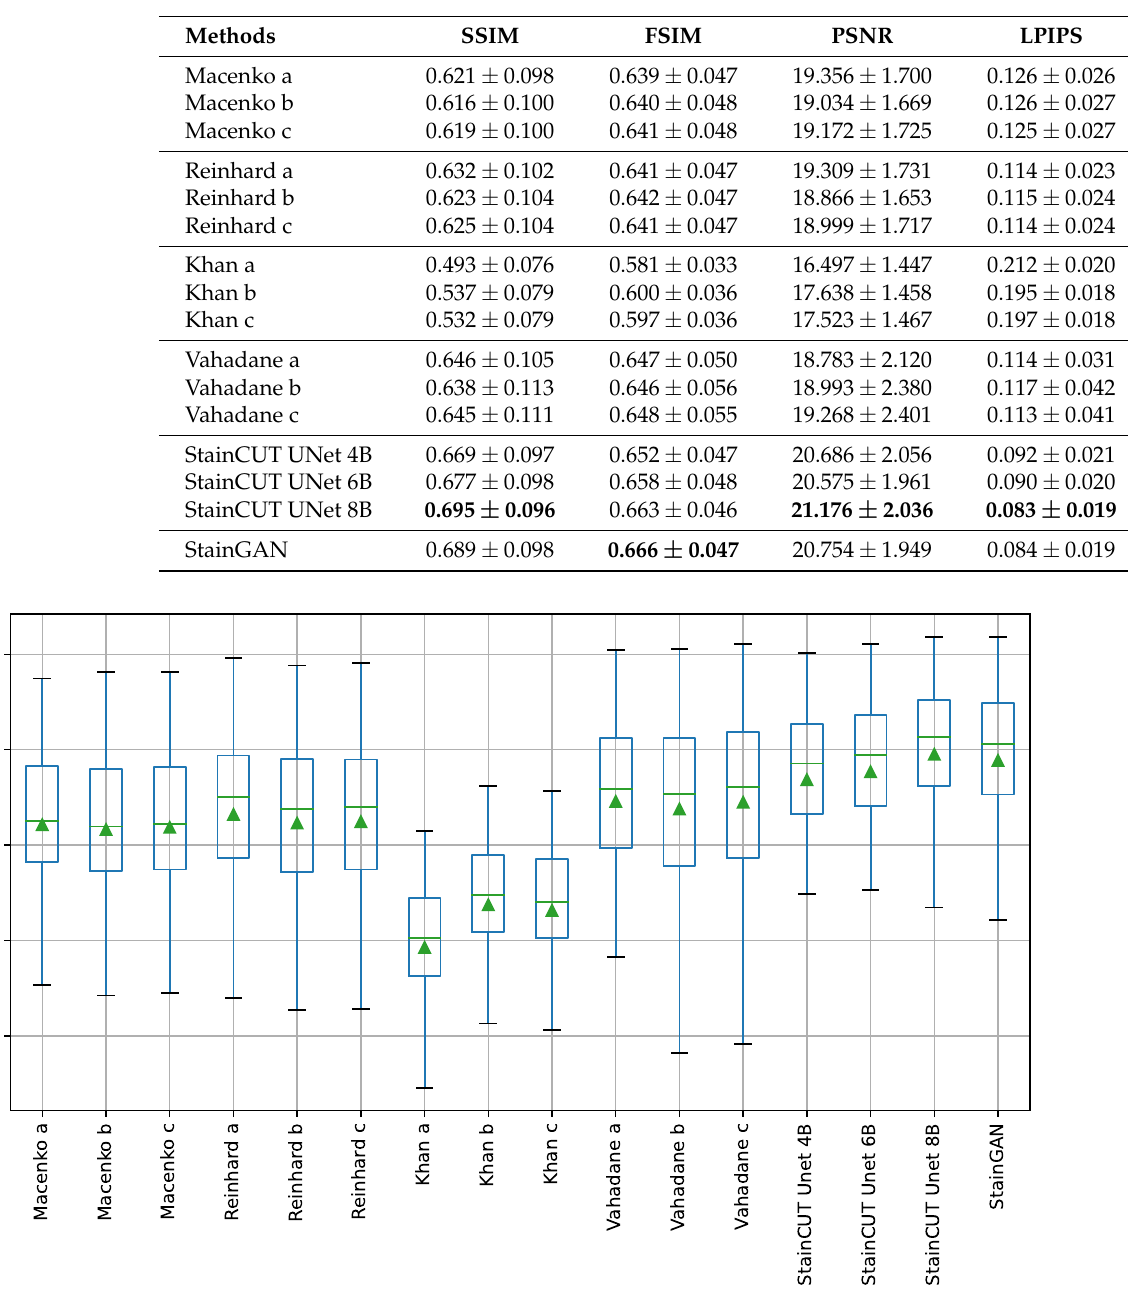
std) for the stain transfer using the images from the Hamamatsu Table 4. Evaluation metrics (mean ± Scanner as reference. Bold highlights the best results for each metric.